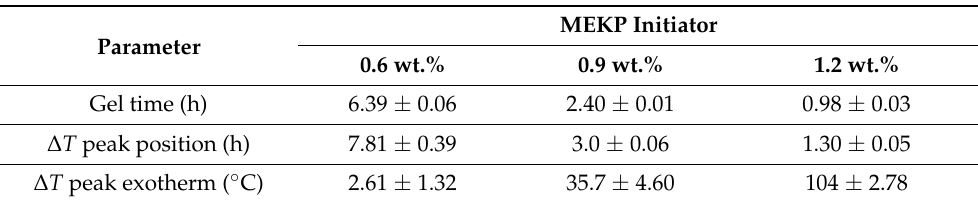
Table 3. Gel time and peak exotherm (average and one standard deviation) measured on 14 mL cups for different MEKP concentrations.